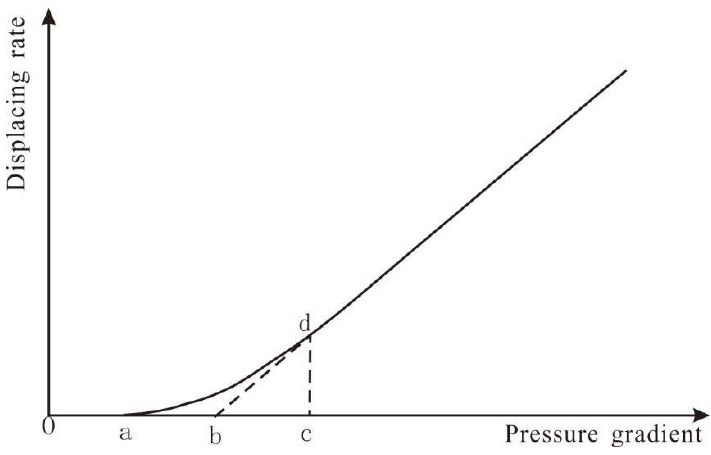
Figure 9. Typical gas flow curve in low-permeability sandstone.